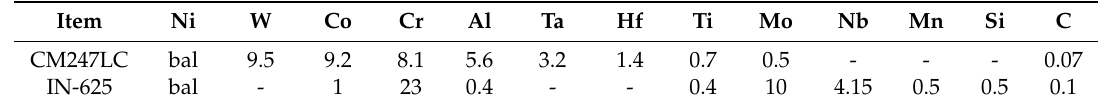
Table 1. Chemical compositions of CM247LC and IN-625 (wt